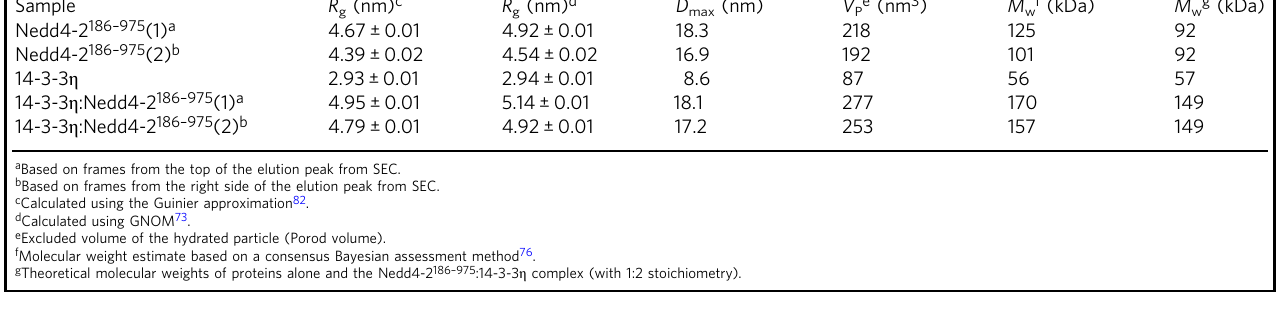
Table 3 Structural parameters determined from SEC-SAXS data. Sample